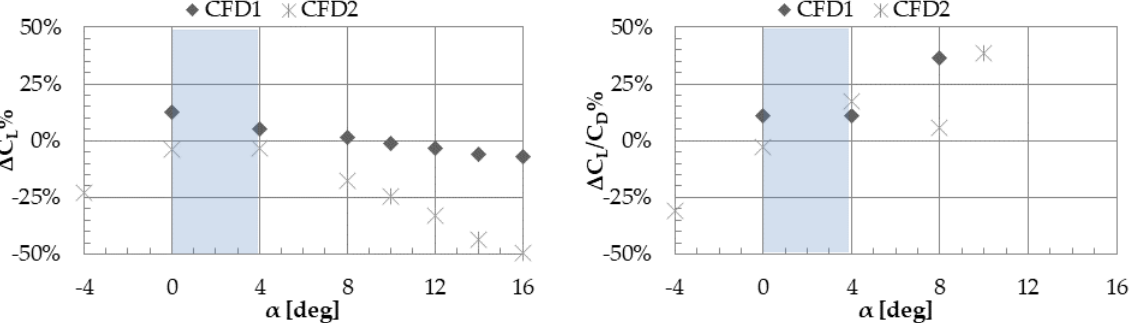
Figure 11. Percentage differences on centre of pressure ( 𝑋 𝐶𝑃 , left ) and neutral point ( 𝑋 𝑁𝑃 , right ) longitudinal positions predictions (SD2020 underestimates when values are positive).